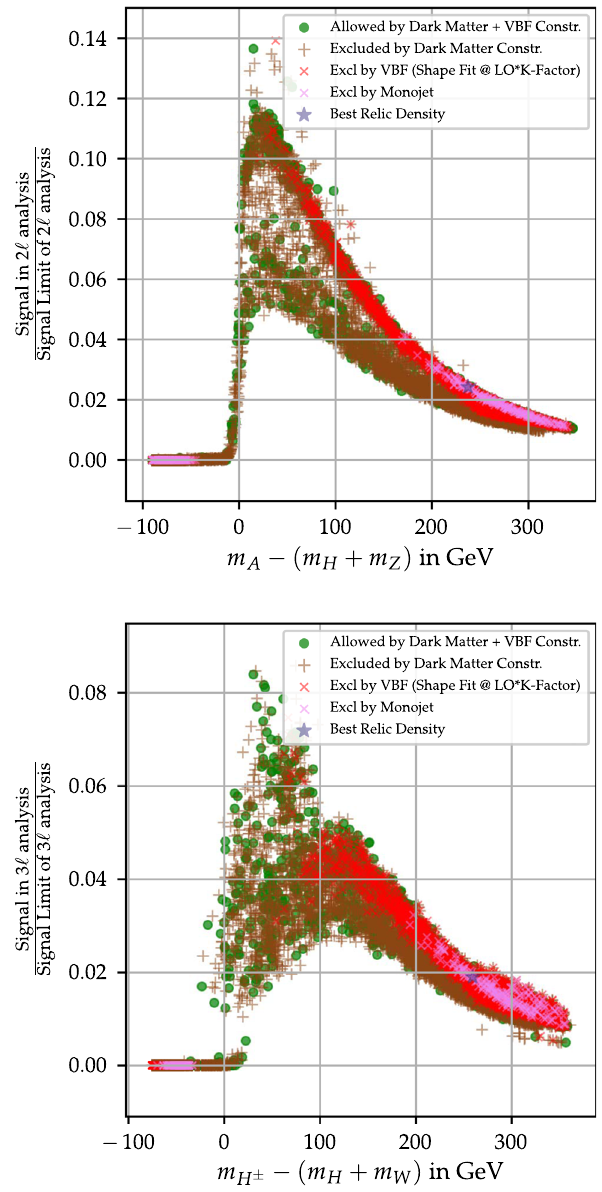
Fig. 6 Results for our LHC reinterpretation of SUSY electroweakino results on the masses of the IDM. The x -axis shows mass differences which are strongly correlated to the MET distribution in the final state. The y -axis denotes the r -value, defined as the ratio of the signal pre- diction divided by the 95 % confidence limit on the signal